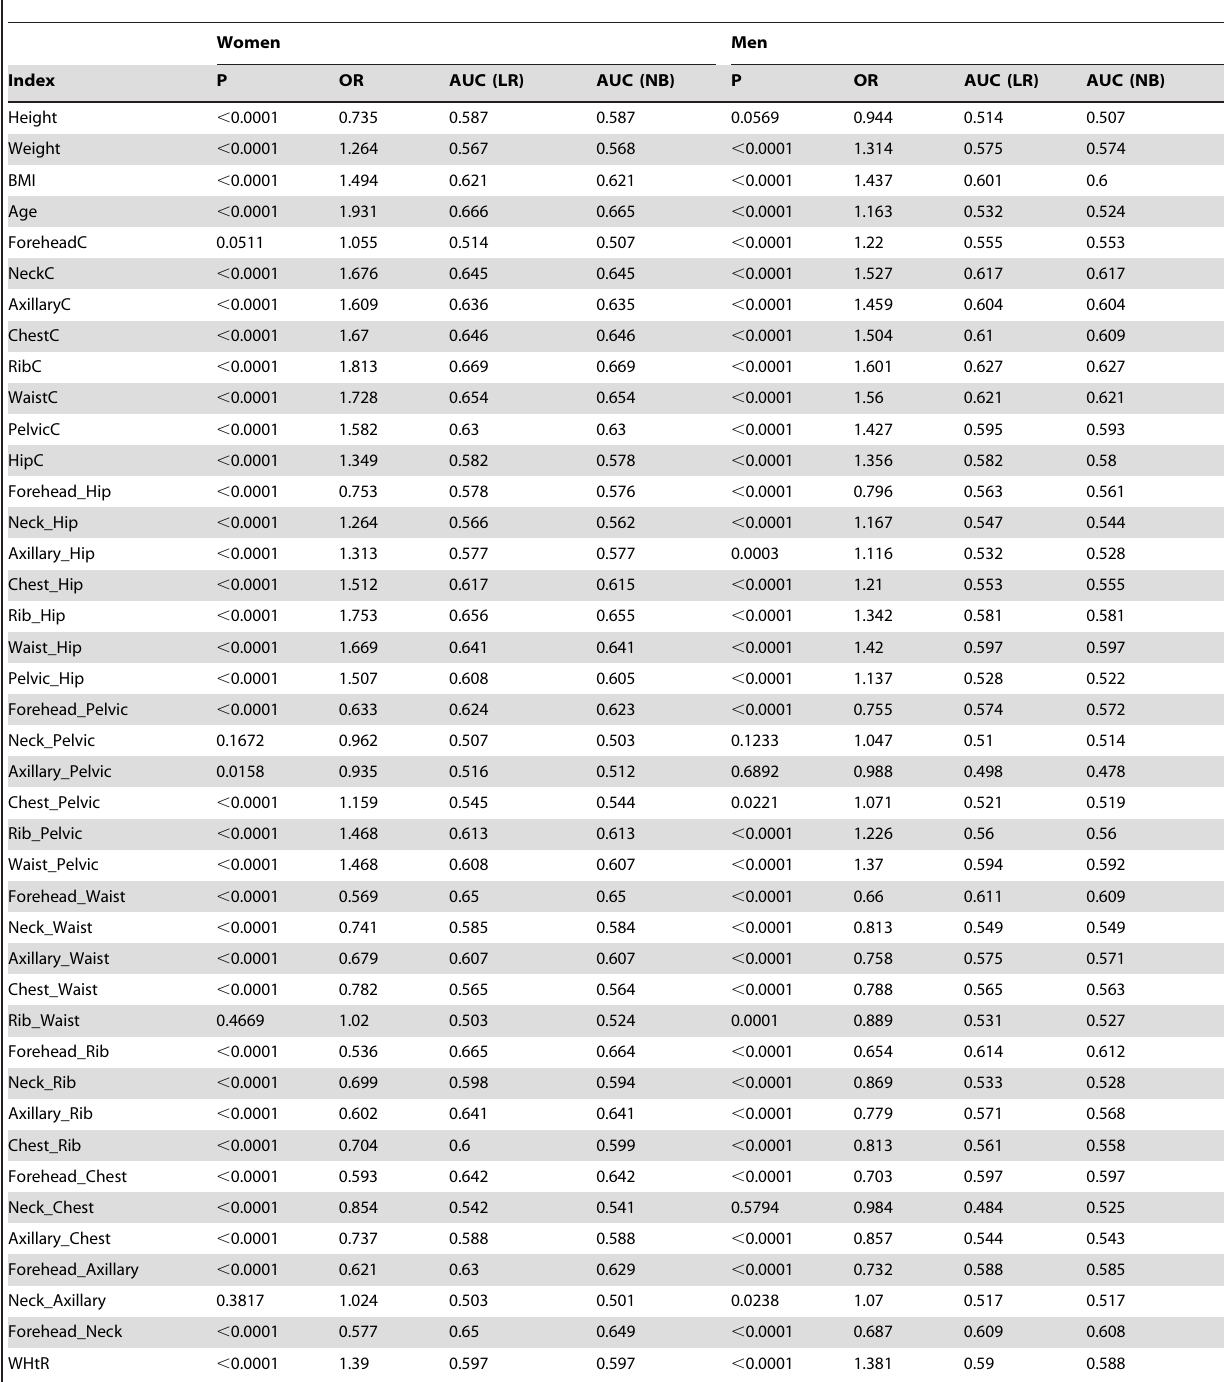
Table 2. Statistical analysis of normotension vs. hypertension in women and men.